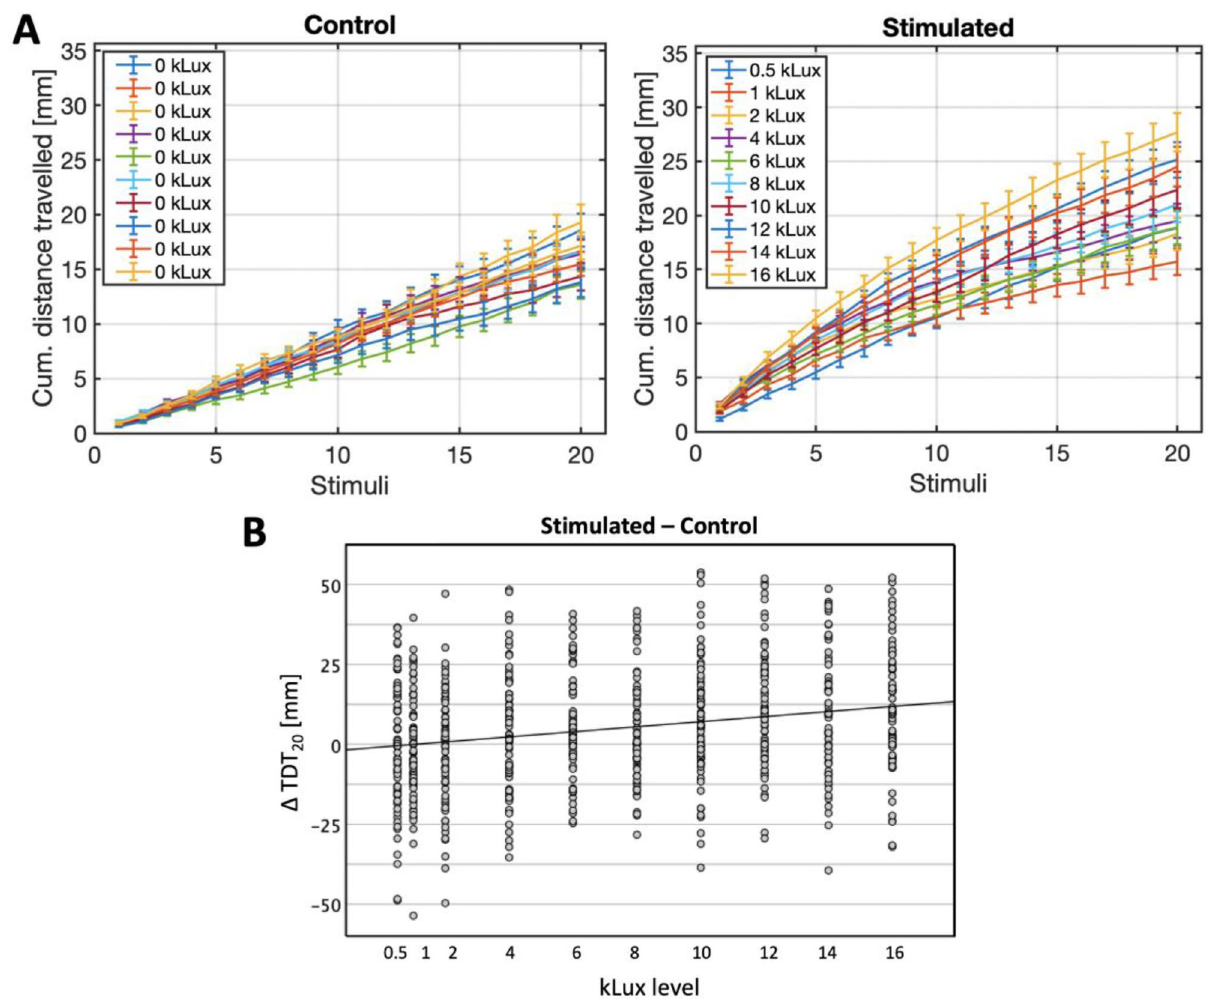
Figure 1. ( A ) Mean distance travelled (± 1 SE) cumulatively over stimuli, for the stimulated group (right panel) and the respective—with same line colour—control group (left panel), at each kLux level. ( B ) Mean change in TDT 20 (± 1 SE) of the stimulated group relative to the control, at each kLux level (each dot represents a single larva). The predictive model was: Δ TDT 20 = − 0.84 + 0.794*(kLux